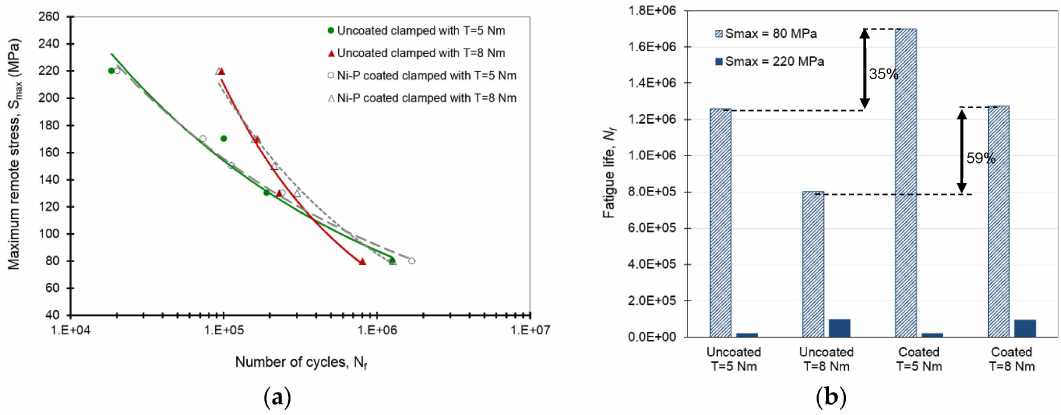
Figure 2. ( a ) Fatigue life results for uncoated and Ni–P coated aluminum alloy 7075-T6 joints